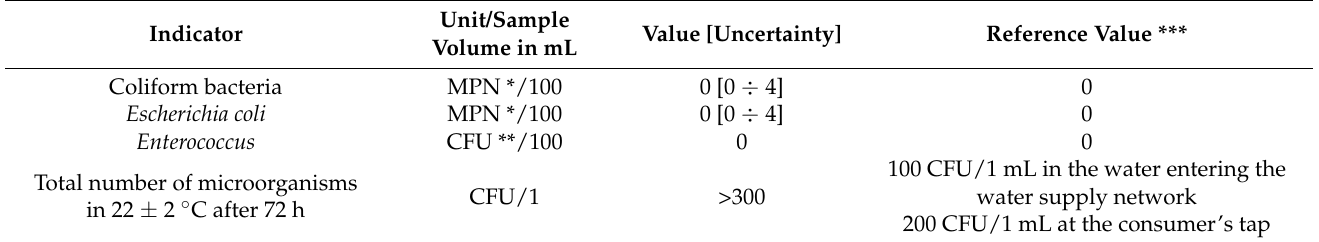
Table 3. Microbiological characteristics of the tested water.